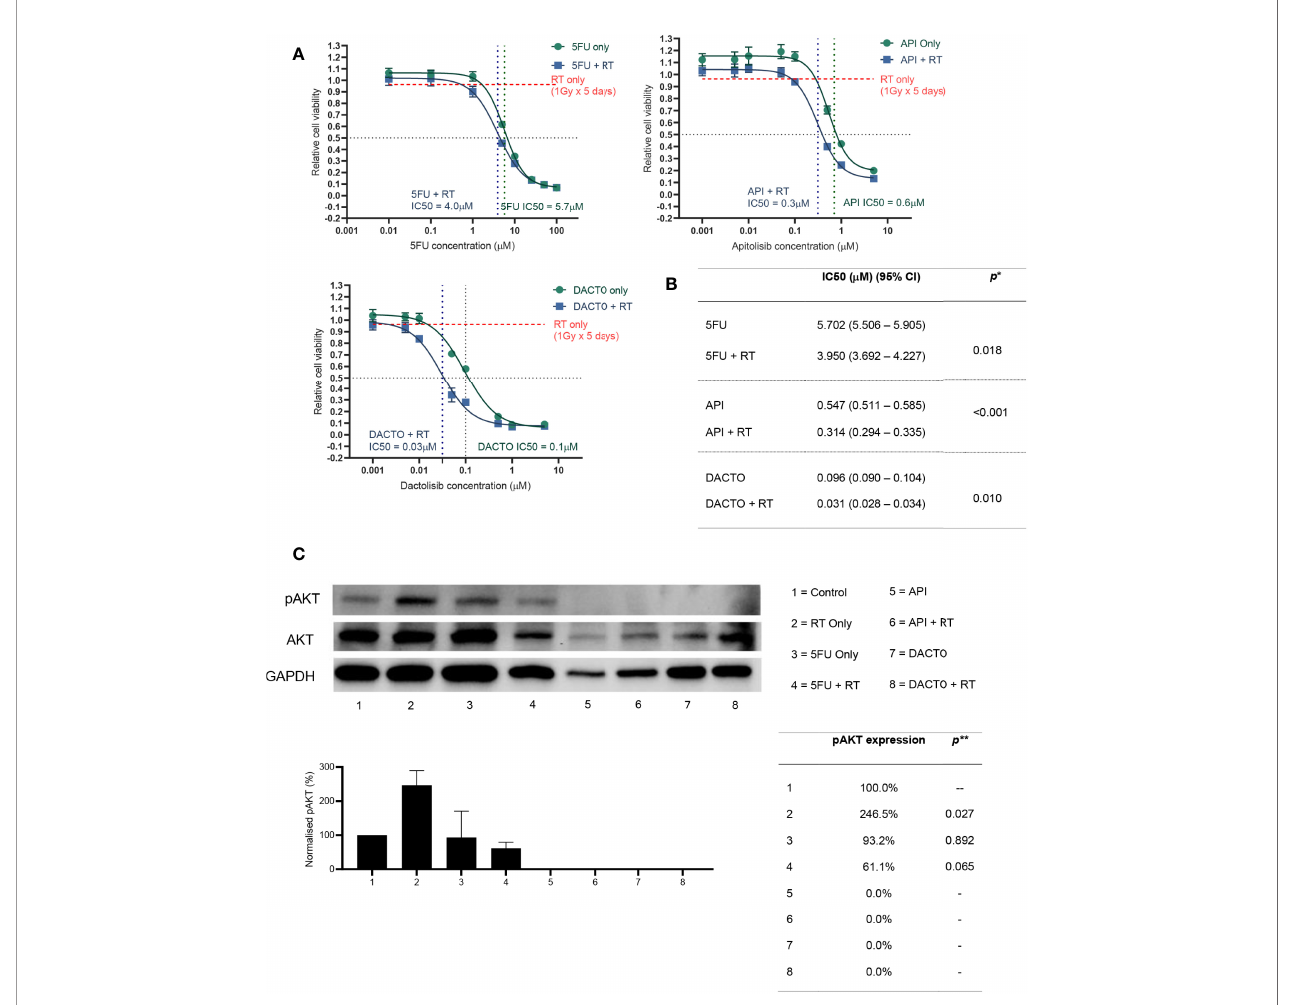
FIGURE 6 | Radiosensitizing HCT116 and its AKT phosphorylation status following drug and/or radiotherapy treatment. (A) HCT116 was treated with eight different concentrations of 5-FU, Apitolisib or Dactolisib, with or without radiotherapy (1Gy fractions over 5 days). End-point cell viability was assessed using CellTiter-Glo 2.0 (Promega, USA) and chemiluminescence. The data is presented normalised to control (containing 0.1% DMSO) versus log transformed drug dose concentrations ( m M). (B) Half maximal inhibitory concentrations (IC50) for each of the drugs with or without radiotherapy were obtained using Prism (Graphpad, USA). A statistically signi fi cant difference in radiosensitisation across all three drugs (radiotherapy effect; Two-way ANOVA test*, p < 0.0001) and between the different drug doses (drug effect: p < 0.0001*). (C) Results from western blot analysis of protein extracted from HCT116 following a 72-hour incubation with or without the three drugs (5FU- 5 m M; Apitolisib-100nM, Dactolisib-100nM), and with or without a single 5Gy dose of radiotherapy. Image densitometry was performed and relative pAKT expression has been demonstrated normalised to control (containing 0.1% DMSO). Protein was extracted two-hours after irradiation. Irradiation alone led to a signi fi cant increase in AKT phosphorylation at two-hours (p=0.027; two-tailed T-test**). Treatment with Dactolisib and Apitolisib with or without radiotherapy led to complete inhibition of AKT phosphorylation across three independent repeat experiments. API, Apitolisib; DACTO, Dactolisib; RT, radiotherapy; CI, con fi dence interval; pAKT, phosphorylated AKT; DMSO, Dimethyl